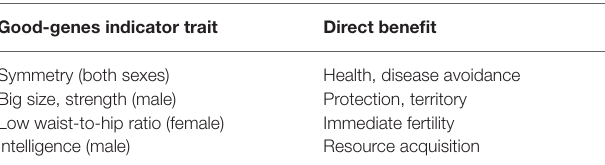
TABLE 2 | Frequently cited good-genes indicator traits and their alternative direct benefits interpretation. Good-genes indicator trait Direct